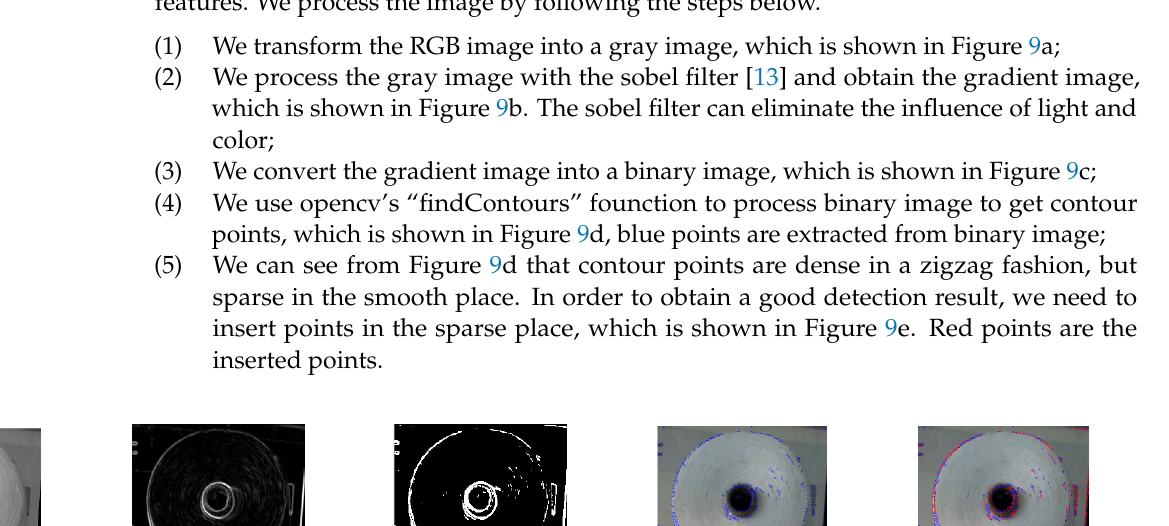
Figure 8. Center detection process.